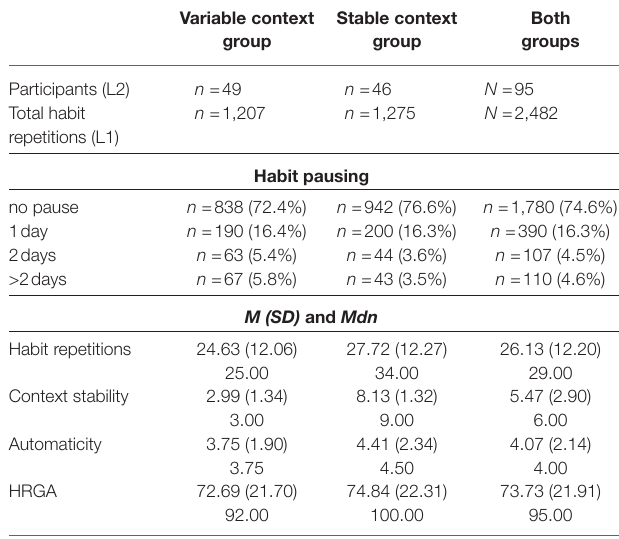
TABLE 1 | Descriptive statistics for the stable and variable context